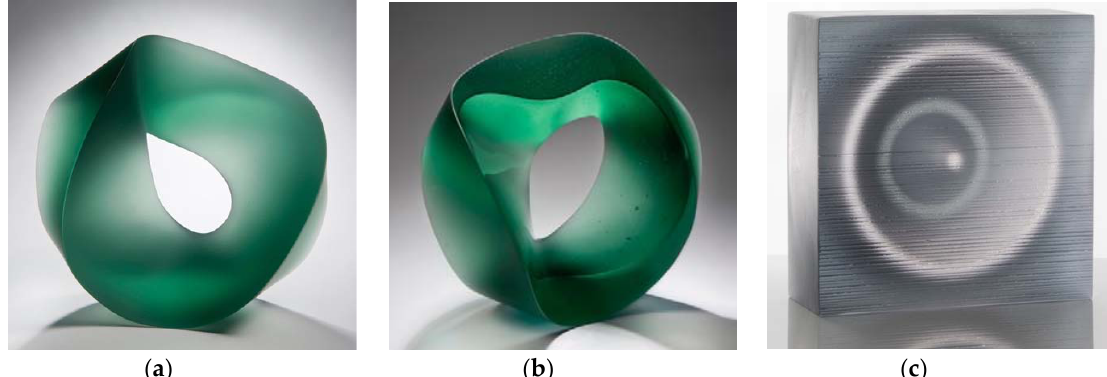
Figure 5. Surface finish of glass. ( a ) Heike Brachlow, Apophasis 2016, cast glass, fine matte surface, 30 × 31 × 27 cm, photograph by Ester Segarra, courtesy of the artist. ( b ) Heike Brachlow, Nimbus, 2018, cast glass, one surface polished, 36 × 38 × 31 cm, photograph by Ester Segarra, courtesy of the artist. ( c ) Richard Whiteley, Light cone, 2013, cast glass, 33.5 × 33.5 × 13 cm, rough sawn and sealed surface. Photograph by Greg Piper, courtesy of the artist.